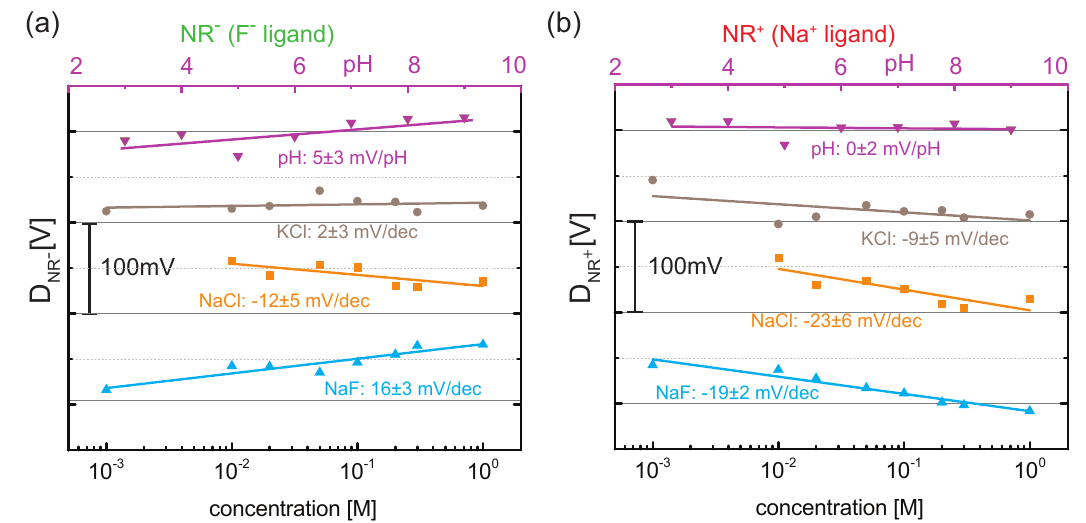
− (F − ligand) and ( b ) differential = V − V Figure 4. ( a ) differential response ( D th ;NR c ) for NR th ;NR − NR − + (Na + ligand). In the case of NaF, the simultaneous = V − V response ( D th ;NR c ) for NR th ;NR + NR + detection of fluoride and sodium ions is achieved. Note that the pH has been changed by six orders of magnitudes (top horizontal axis) compared to three orders of magnitudes for the salt concentration (bottom horizontal axis).